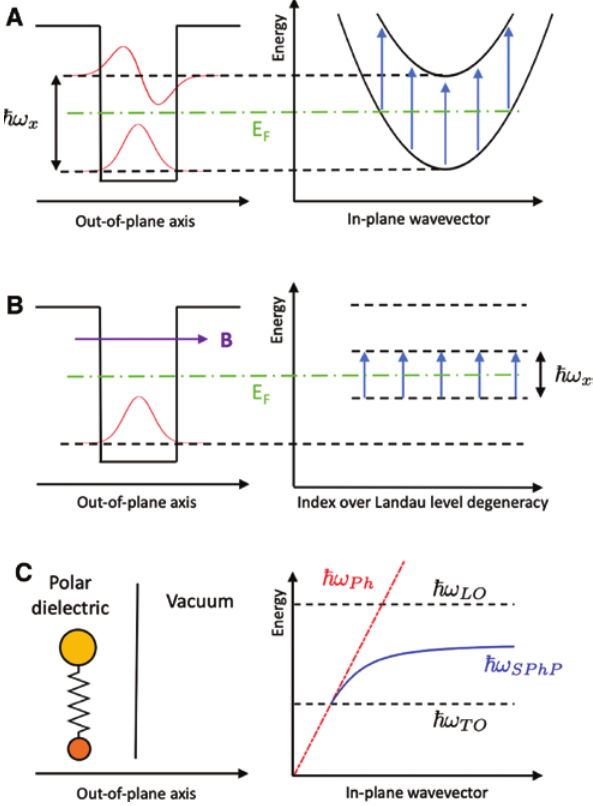
Figure 4: Sketch of the three different long-wavelength polaritonic platforms discussed in the main text.